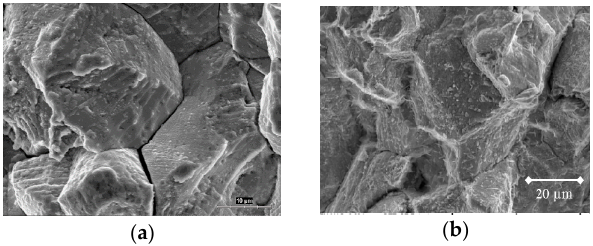
Figure 9. The fracture surface appearance showing IG fracture of Irradiation Assisted Stress Corrosion (IASCC) in tensile specimens made from irradiated 18Cr-10Ni-Ti steel and SSRT by 1 × 10 − 7 s − 1 at high temperature water at 320 °C [13]: ( a ) the specimen irradiated in the fast reactor (BOR-60, T ir = 320 °C, 12.6 dpa); ( b ) the specimen fabricated of the in-service irradiated steel (WWER, T ir = 320 °C, 5.2 dpa). Copyright 2011 by The Minerals, Metals & Materials Society. Used with permission.